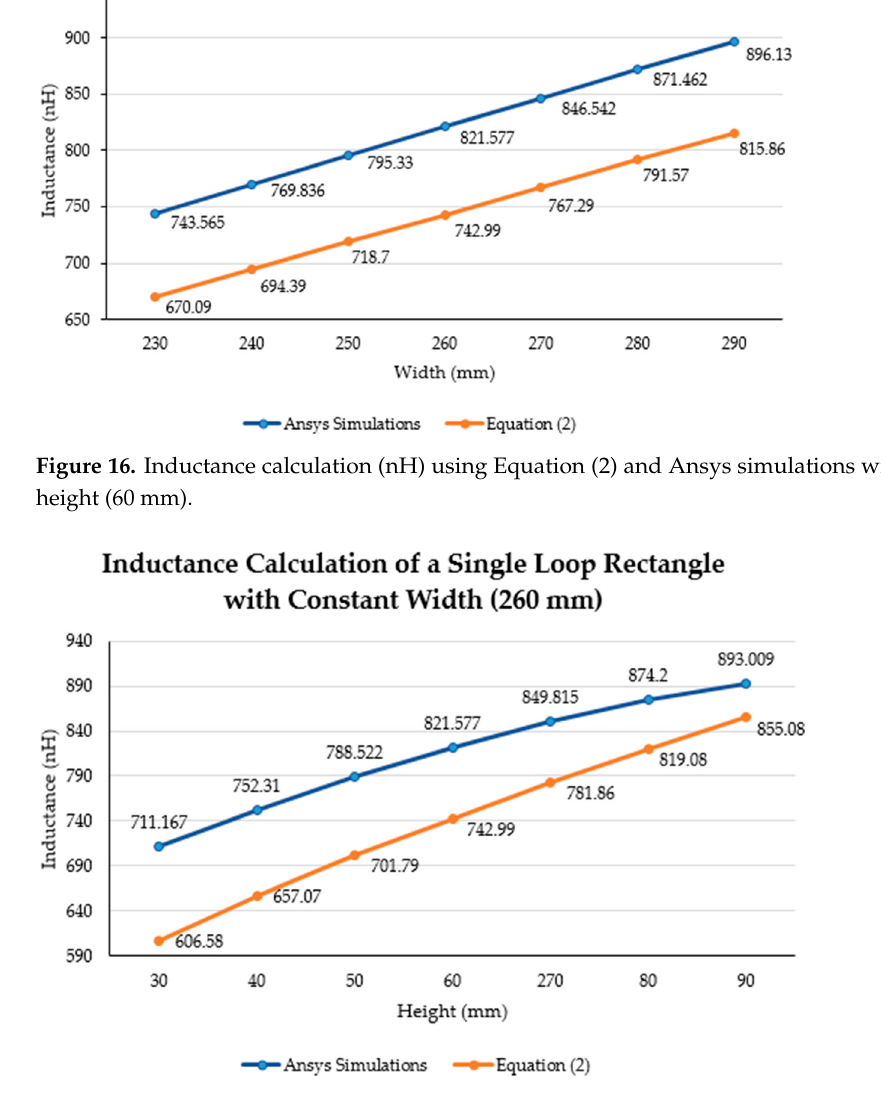
Figure 17. Inductance calculation (nH) using Equation (2) Ansys simulations with a constant width (260 mm).